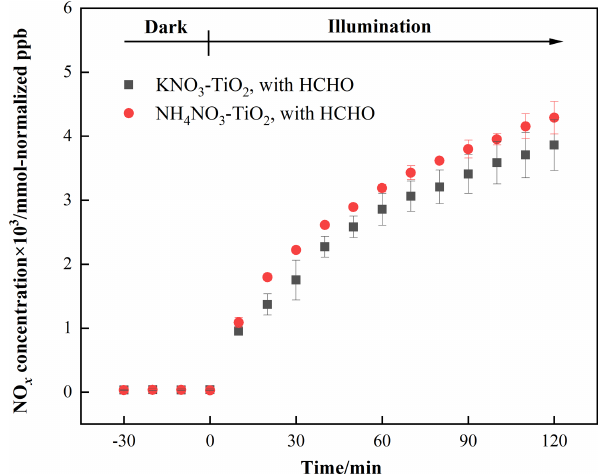
Figure 3. Effect of formaldehyde on the renoxification processes of 4wt% NH 4 NO 3 –TiO 2 and 4wt% KNO 3 –TiO 2 particles at 293K and 0.8% of relative humidity; 365nm LED lamps were used dur- ing the irradiation experiment. The initial concentration of HCHO was about